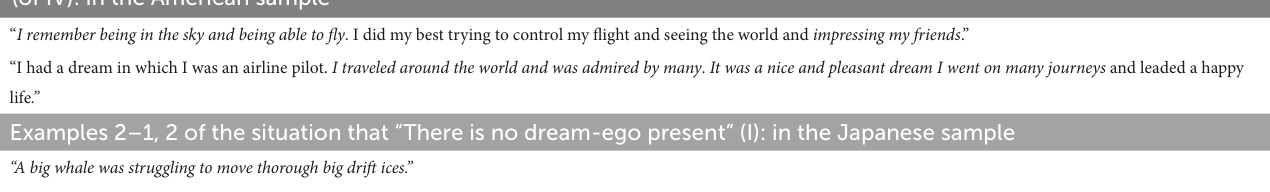
TABLE 5 Examples of the structural patterns identified in the American and the Japanese samples for “impressive dreams in childhood”. Examples 1–1, 2 of the situation that “The dream-ego succeeds in moving towards and reaching the desired destination” (of IV): in the American sample “ I remember being in the sky and being able to fly . I did my best trying to control my flight and seeing the world and impressing my friends .” “I had a dream in which I was an airline pilot. I traveled around the world and was admired by many . It was a nice and pleasant dream I went on many journeys and leaded a happy life